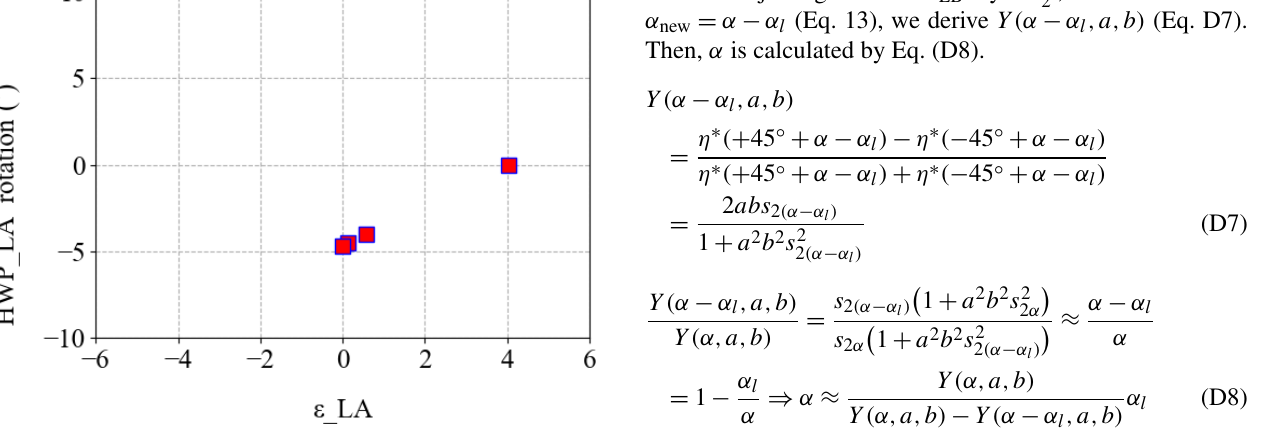
Figure C1. The test performed for zeroing ε LA , for defining the polarization of i LA with respect to the